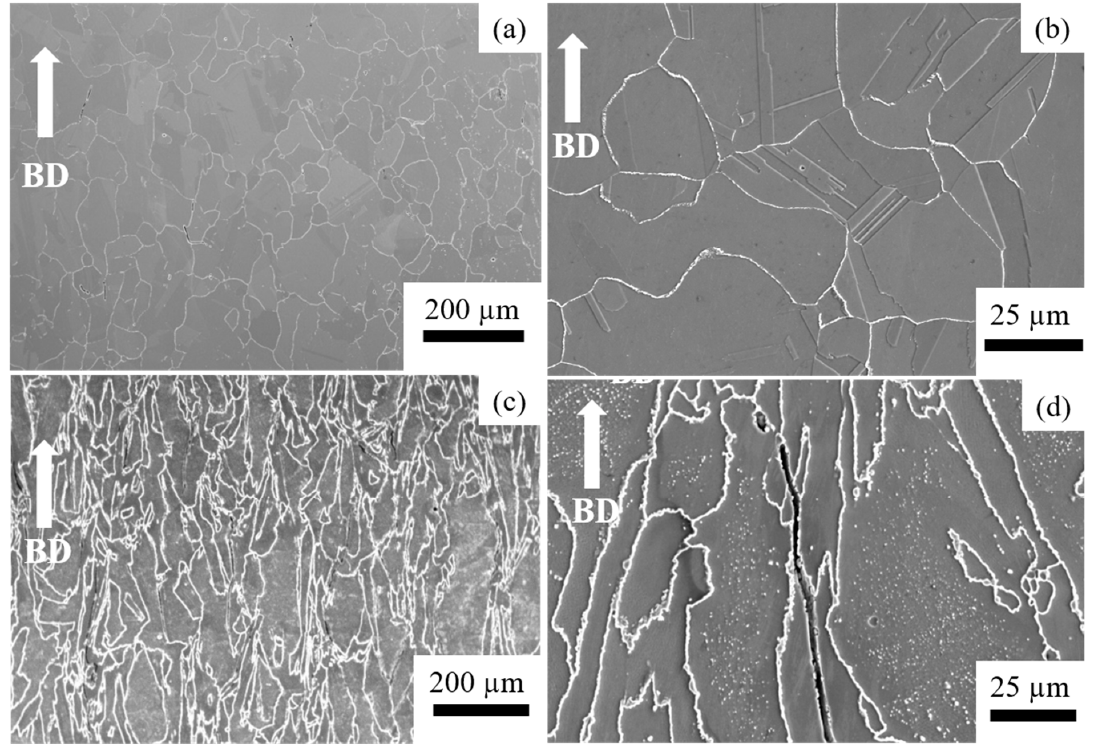
Figure 6. SEM micrographs of the solution heat treatment (ST) HX specimen at ( a ) low magnification and ( b ) high magnification, and HX-a ST specimen at ( c ) low magnification and ( d ) high magnification.